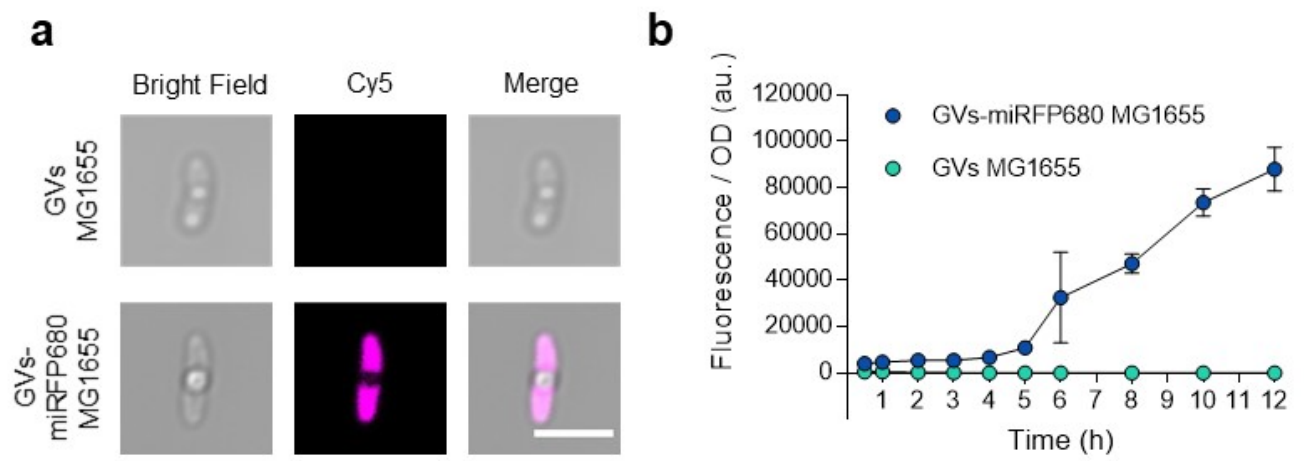
Figure 5. In vitro optical imaging of GVs-miRFP680 MG1655. ( a ) Confocal images of GVs MG1655(control) and GVs-miRFP680 MG1655 in the bright field, cy5 channel (emission: 640 nm, excitation: 663–738 nm), and merged channel, respectively. Scale bars = 5 µm. ( b ) Optical density (OD 600 )-normalized fluorescence as a function of culture time (ex = 661 nm, em = 680 nm). Data represent the mean ± SD from 3 independent experiments.